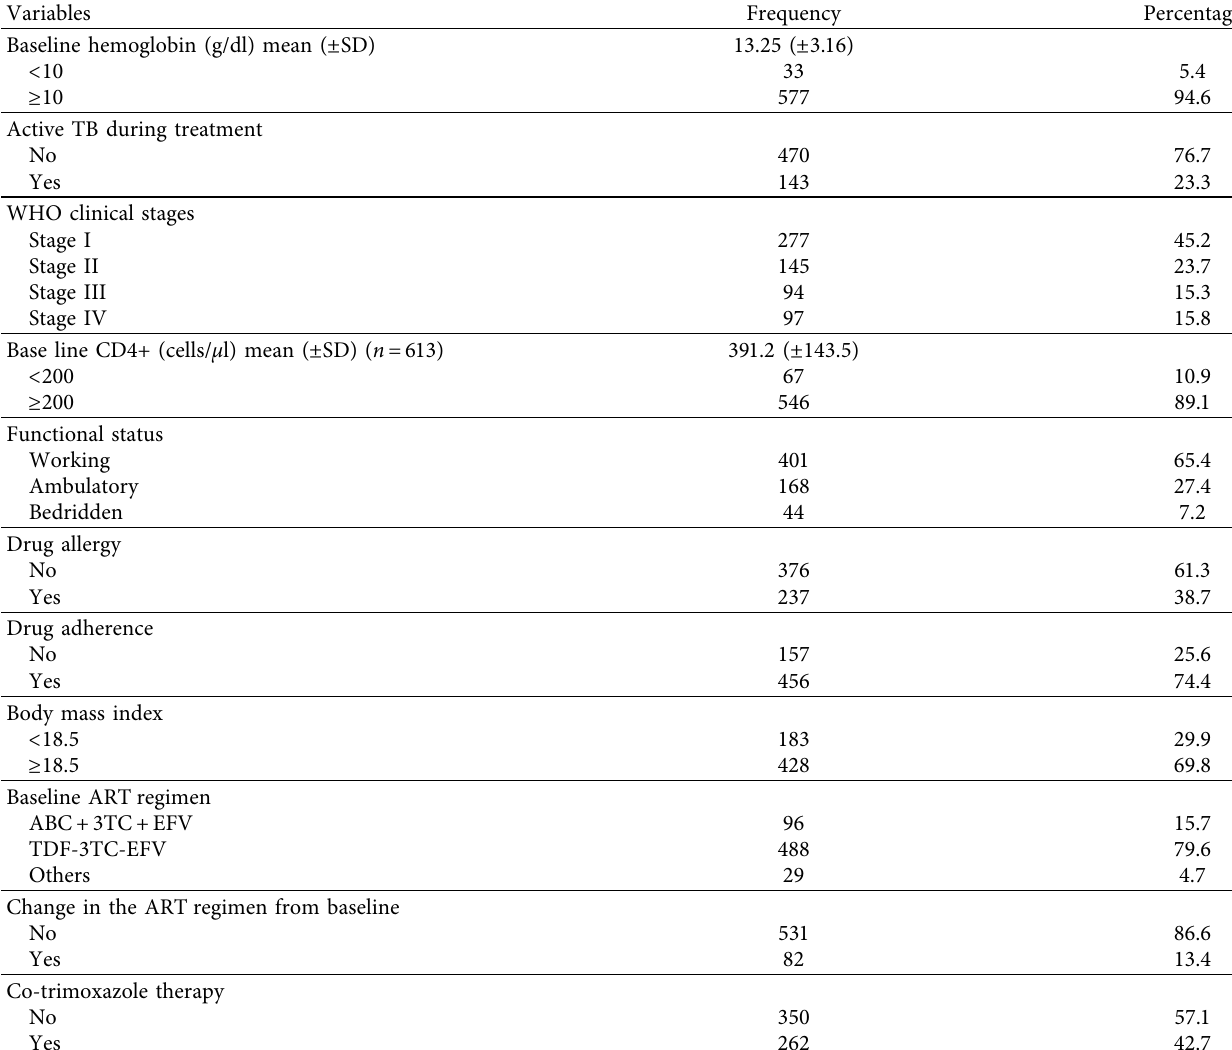
Table 2: Clinical characteristics of patients under ART in health centers at Kirkos subcity Addis Ababa, Ethiopia, 2014–2019. Variables